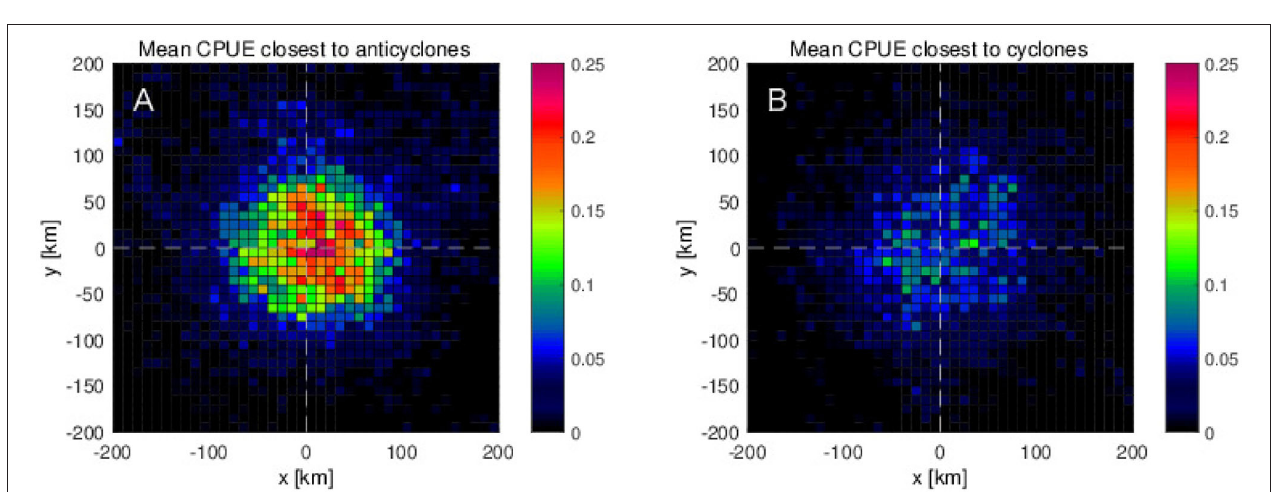
FIGURE 7 | Mean CPUE as a function of distances from the center of eddies along zonal and meridional directions for (A) anticyclonic eddies (or warm-core rings: WCR) and (B) cyclonic eddies (or cold-core rings: CCR), which are closest to each swordfish fishing position.